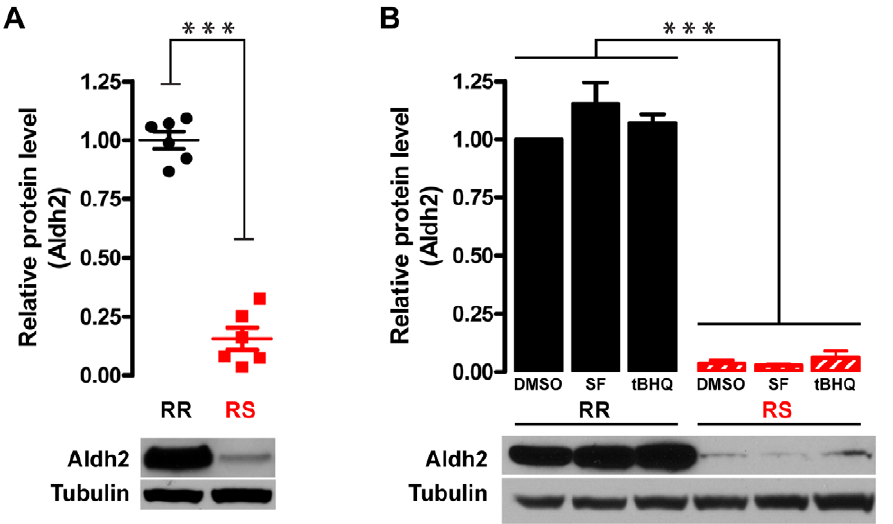
Figure 8. Differential expression of Aldh2 at baseline and following activation of Nrf2 pathway. A . At baseline, Aldh2 protein level (apparent MW, 51 kDa) in the whole cell lysate is significantly lower in CRI-G1-RS than in CRI-G1-RR cells. Statistical significance was determined by two-tailed Student’s t-test; scatter plot of all data points is shown. B. Aldh2 expression was not affected by 24 h treatment with 5 m M SF or 10 m M tBHQ (two activators of Nrf2 pathway) in either cell type; regardless of the treatment, Aldh2 expression level was significantly lower in CRI-G1-RS than in CRI-G1-RR cells. Statistical significance was determined by two-way ANOVA; data are plotted as mean 6 S.E.M. (n=5). ***, p , 0.001.